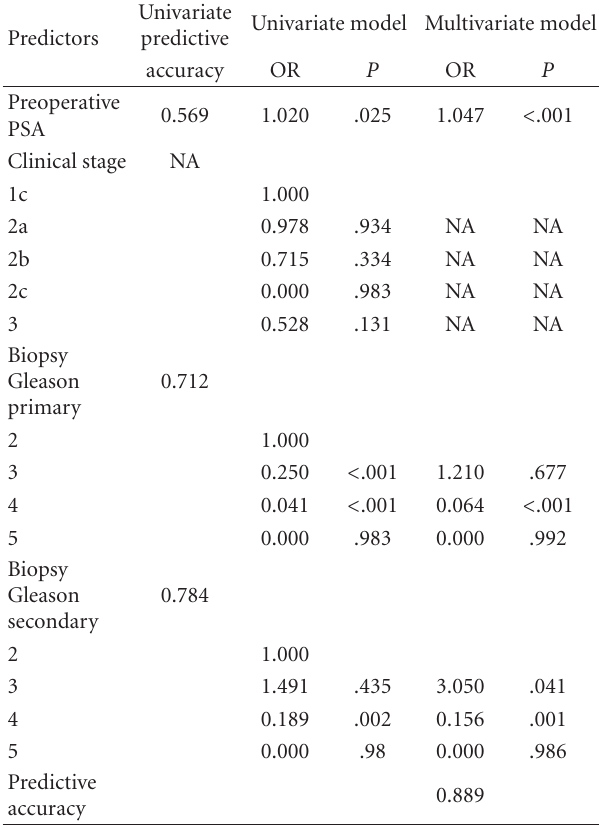
Table 2: Uni- and multivariate logistic regression models predict- ing significant Gleason sum